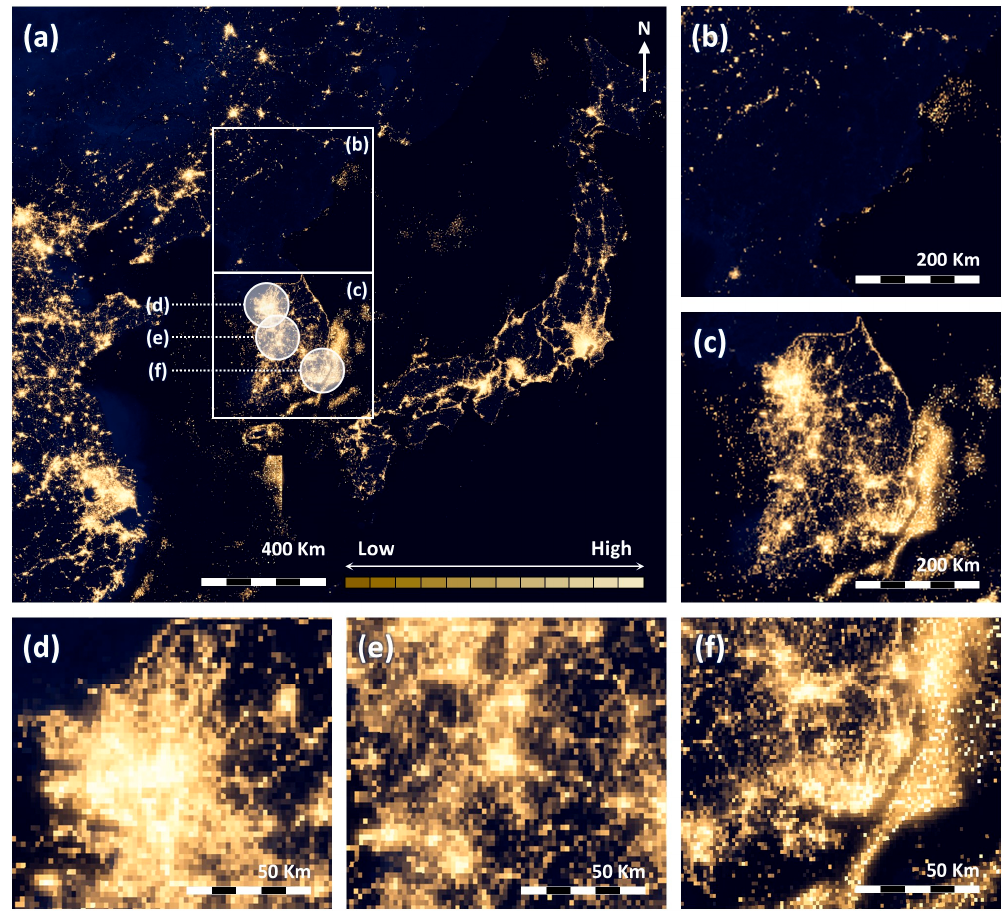
Figure 1. Spatial patterns of the Defense Meteorological Satellite Program Optical Linescan System (DMSP-OLS) night-time lights on major cities: ( a ) Cities in East Asian countries including the Korean peninsula, ( b ) cities in North Korea, ( c ) cities in South Korea, ( d ) Seoul, ( e ) Daejeon, and ( f ) Busan.